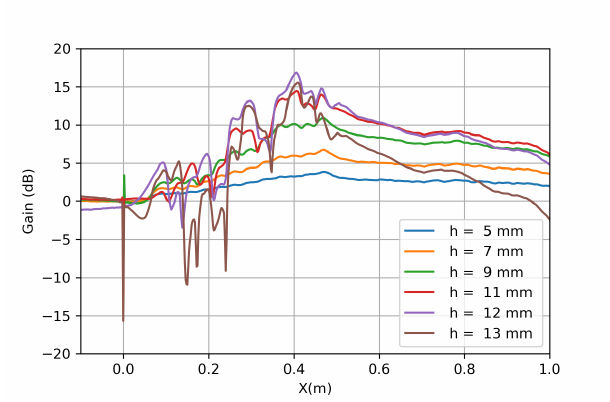
FIGURE 6. Simulated horizontal gain versus substrate thickness along a line lying in the horizontal plane (near field raised 3 cm above the ground